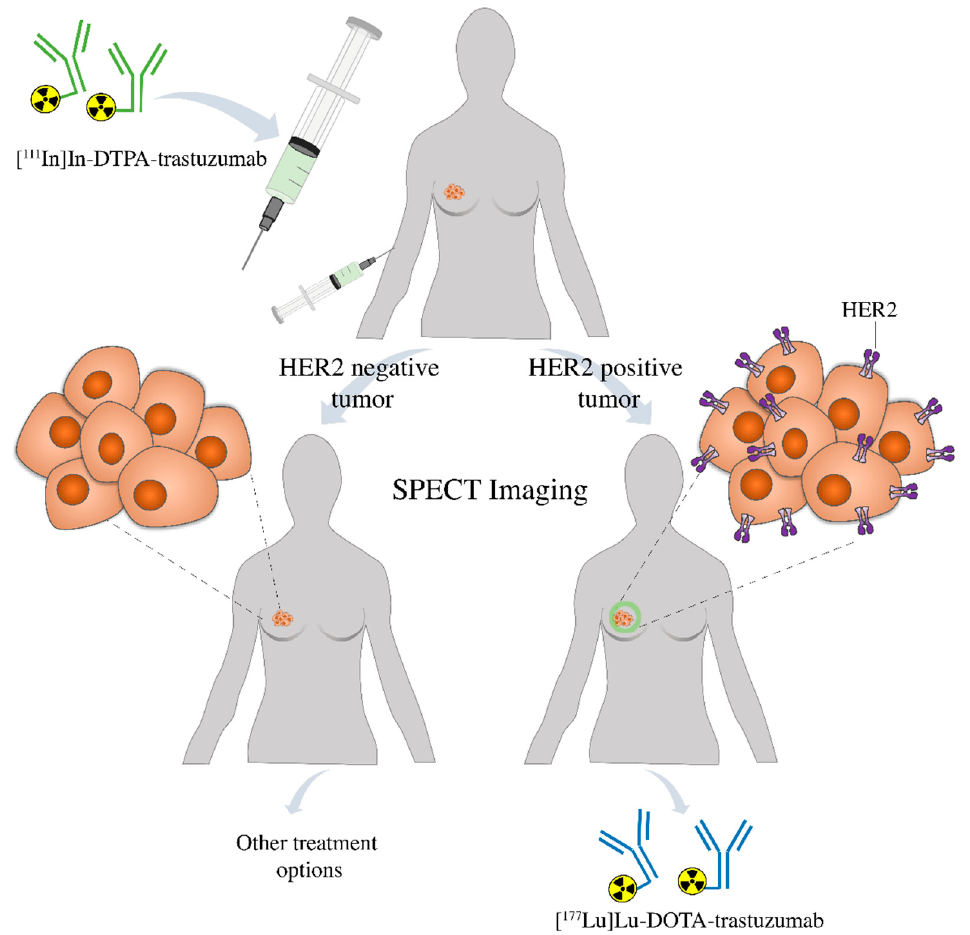
Figure 8. Patient prescreening with [ 111 In]In-DTPA-trastuzumab using SPECT imaging prior to therapy allows the identification of individuals positive to HER2 that are more likely to respond to the treatment with [ 177 Lu]Lu-DOTA-trastuzumab or be changed to an alternative treatment strat- egy.